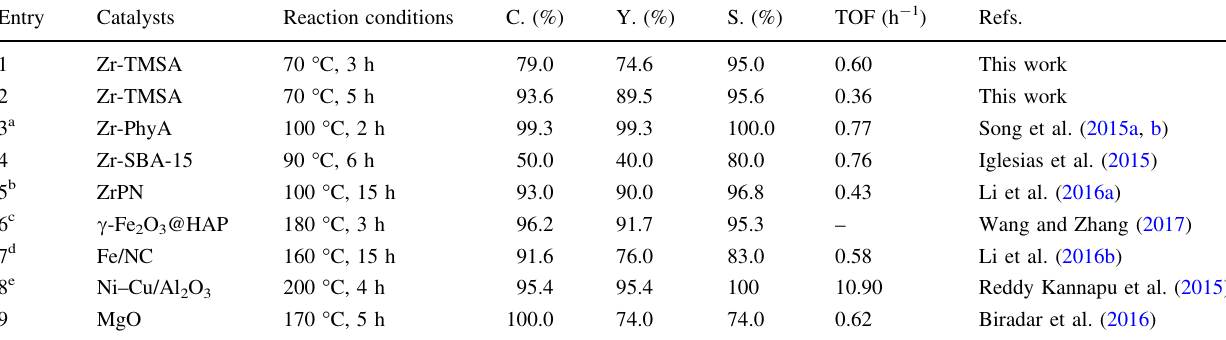
Table 2 Comparison of Zr-TMSA catalyst with different catalysts in typical literatures Entry